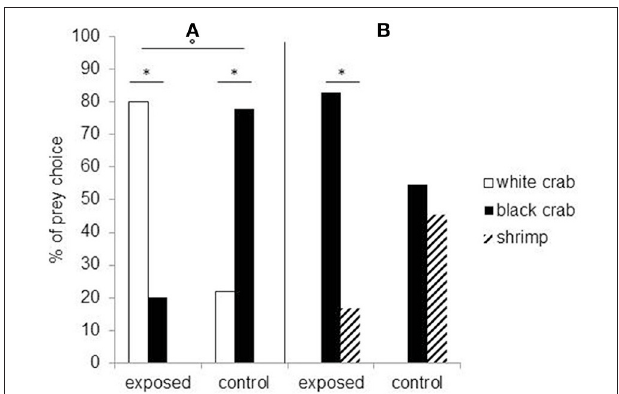
FIGURE 3 | Seven-day-old cuttlefish’s prey choice depending on whether they have been exposed to white crabs during embryonic development (“exposed”) or not (“control”). (A) To the left of the vertical: when they are presented a choice between white and black crabs. (B) To the right: when they have a choice between black crabs and shrimp. *Significant prey preference within groups (chi-square exact test: p < 0.05) and ◦ significant difference in prey choice between groups (Fisher’s exact test: P < 0.05). Modified from Guibé et al. (2012)